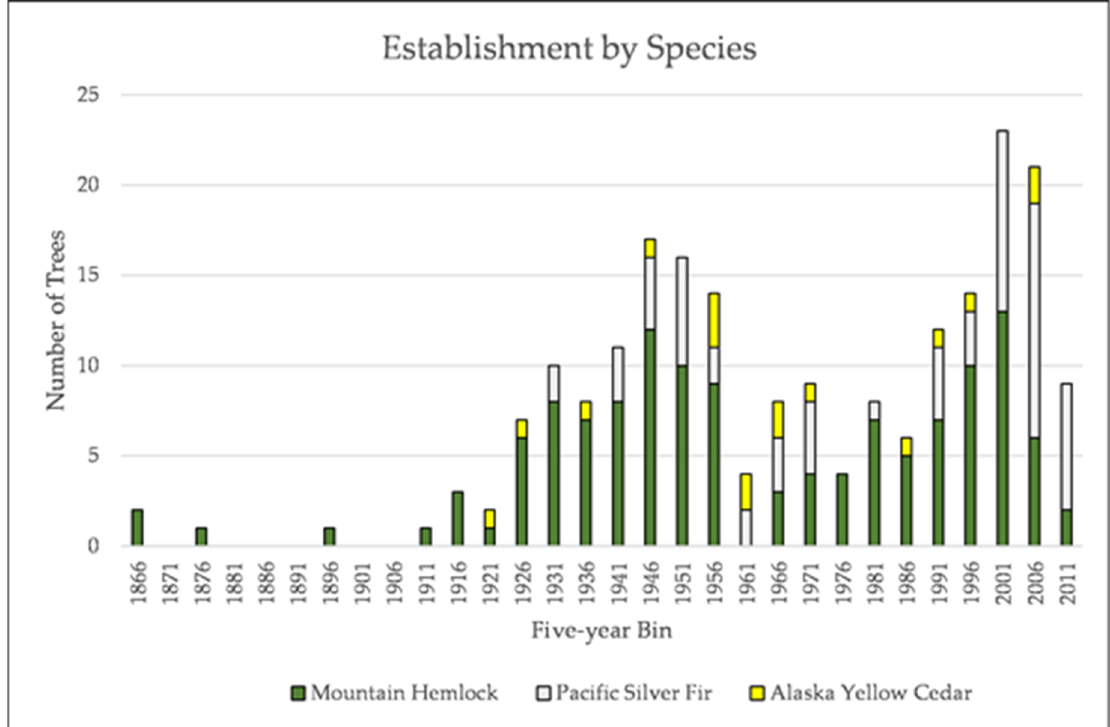
Figure 4. Total number of trees of each species that established in each five-year establishment bin for all the transects combined. The dates on the graph are the start dates of each five-year bin. The individual transects show pulses of establishment, except for Grouse Ridge East. Pulses at the remaining transects may not exactly replicate the pulses from the combined data, but they do all have similarities to the overall trend. Scott Paul West and Grouse Ridge West both show two pulses: one centered in the 1940s and 1950s and another cen- tered in the 2000s. Scott Paul east shows the pulse in the 2000s, but it doesn’t show any pulse earlier in the 20th century. 3.2. Climate Relationships Studying annual and seasonal climate variables at the site level shows the differing climate relationships at both sites. There are small, but ecologically important differences in temperature, precipitation (Figure 2), and snowpack (Figure A7) between the Scott Paul and Grouse Ridge sites and these create differences in the limiting factors that inhibit co- nifer establishment. Conifer establishment at Scott Paul tends to be more temperature driven, with strong positive relationships for both annual and growing season tempera- ture (Figure 5). Conifer establishment at Grouse Ridge is more precipitation driven with a strong positive relationship for mean annual precipitation. There is little difference in these relationships between the different species (tree species correlations can be seen in Appendix A8-A17). These relationships remain consistent when viewing the normal Ken- dall’s correlations as opposed to the partial Kendall’s correlations (Appendix A18-A27)